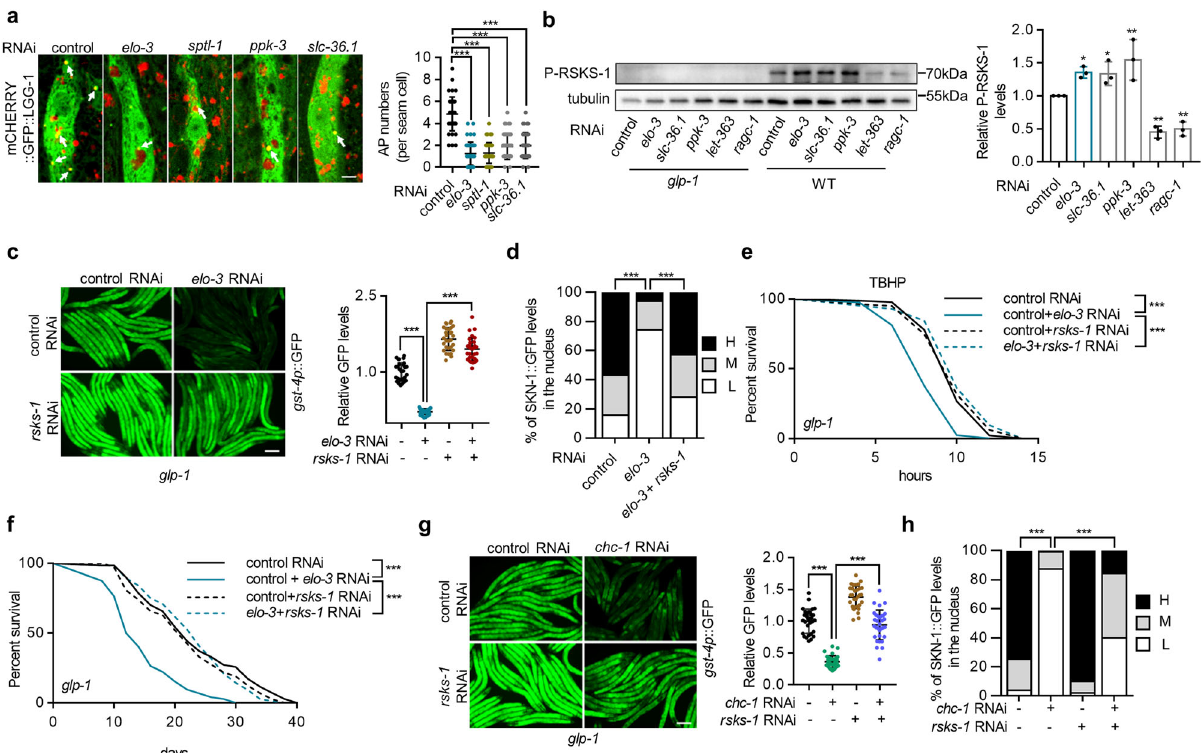
Fig. 7 C22 GlcCer regulates SKN-1 and longevity via TOR. a Effects of elo-3 , sptl-1 , slc-36.1 , and ppk-3 RNAi treatment on the number of APs in seam cells as measured by yellow signals (red + green) from mCHERRY::GFP::LGG-1. White arrows indicate APs. n = 42/44/45/42/42 seam cells for control RNAi/ elo-3 RNAi/ sptl-1 RNAi/ ppk-3 RNAi/ slc-36.1 RNAi. b Effects of RNAi of elo-3 , slc-36.1 , and ppk-3 and TOR component genes on the phosphorylation of RSKS- 1 as measured by immunoblot analysis. n = 3 independent experiments. c – f rsks-1 RNAi treatment restores the expression of gst-4p ::GFP ( c ) ( n = 30 animals), SKN-1 nuclear occupancy ( d ) ( n = 72/91/89 animals for control RNAi/ elo-3 RNAi/ elo-3 + rsks-1 RNAi), TBHP resistance ( e ), and lifespan ( f ) in glp-1 mutants treated with elo-3 RNAi. g, h rsks-1 RNAi treatment restores the expression of gst-4p ::GFP ( g ) ( n = 32 animals) and SKN-1 nuclear occupancy ( h ) ( n = 82/79/99/89 animals for control RNAi/ chc-1 RNAi/ rsks-1 RNAi/ chc-1 + rsks-1 RNAi) in glp-1 mutants with chc-1 knockdown. Data are represented as mean ± SD. ∗∗ p < 0.01, ∗∗∗ p < 0.001. a , c , and g were analyzed by one-way ANOVA with Turkey ’ s multiple-comparison test ( ∗∗∗ p < 0.001). b was analyzed by one-way ANOVA with Holm – Sidak ’ s multiple-comparison test ( ∗∗ p = 0.0065/0.0065/0.0074 for ppk-3/let-363/ragc-1 RNAi, ∗ p = 0.0376/ 0.0376 for elo-3 / slc-36.1 RNAi). d and h were analyzed by Chi-square and Fisher ’ s exact test ( ∗∗∗ p < 0.001). See Supplementary Table 1 and 2 for statistical analysis and additional repeats of the survival assays ( e , f ) that were analyzed by log-rank (Mantel – Cox) test. Scale bar = 3 μ m for panel a , 100 μ m for panels c and g . Source data are provided as a Source Data fi